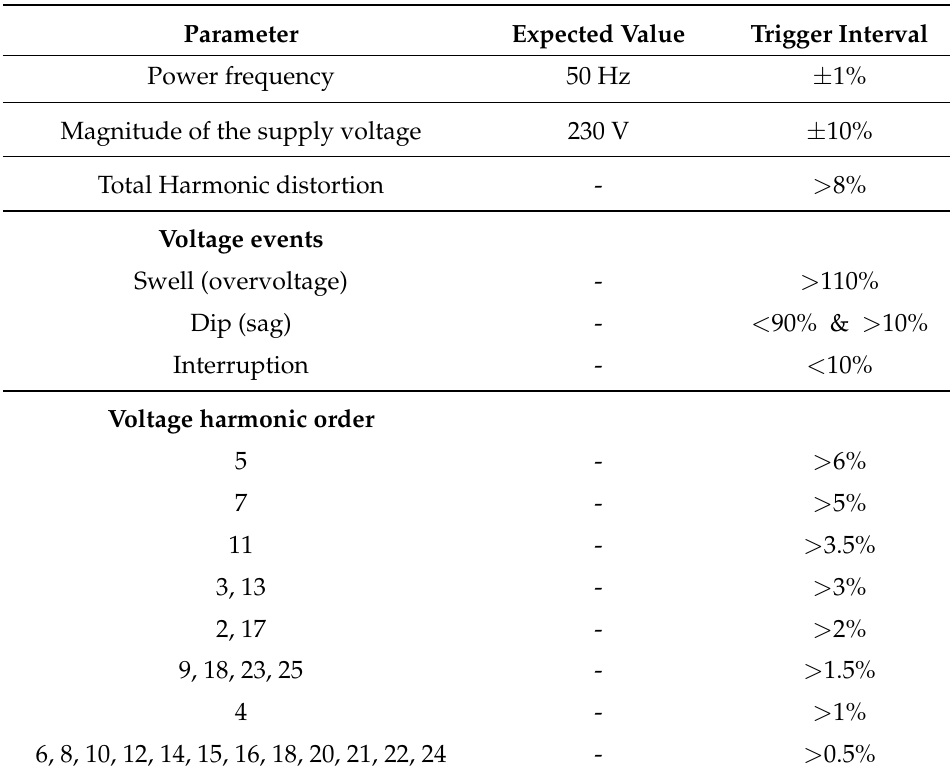
Table 2. PQ parameter reference values and